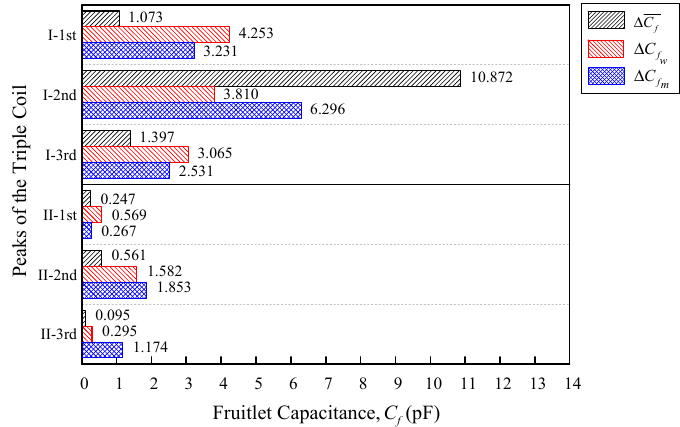
Figure 16. Triple I and II fruitlet capacitance evaluation comparison for ∆ C f , ∆ C f